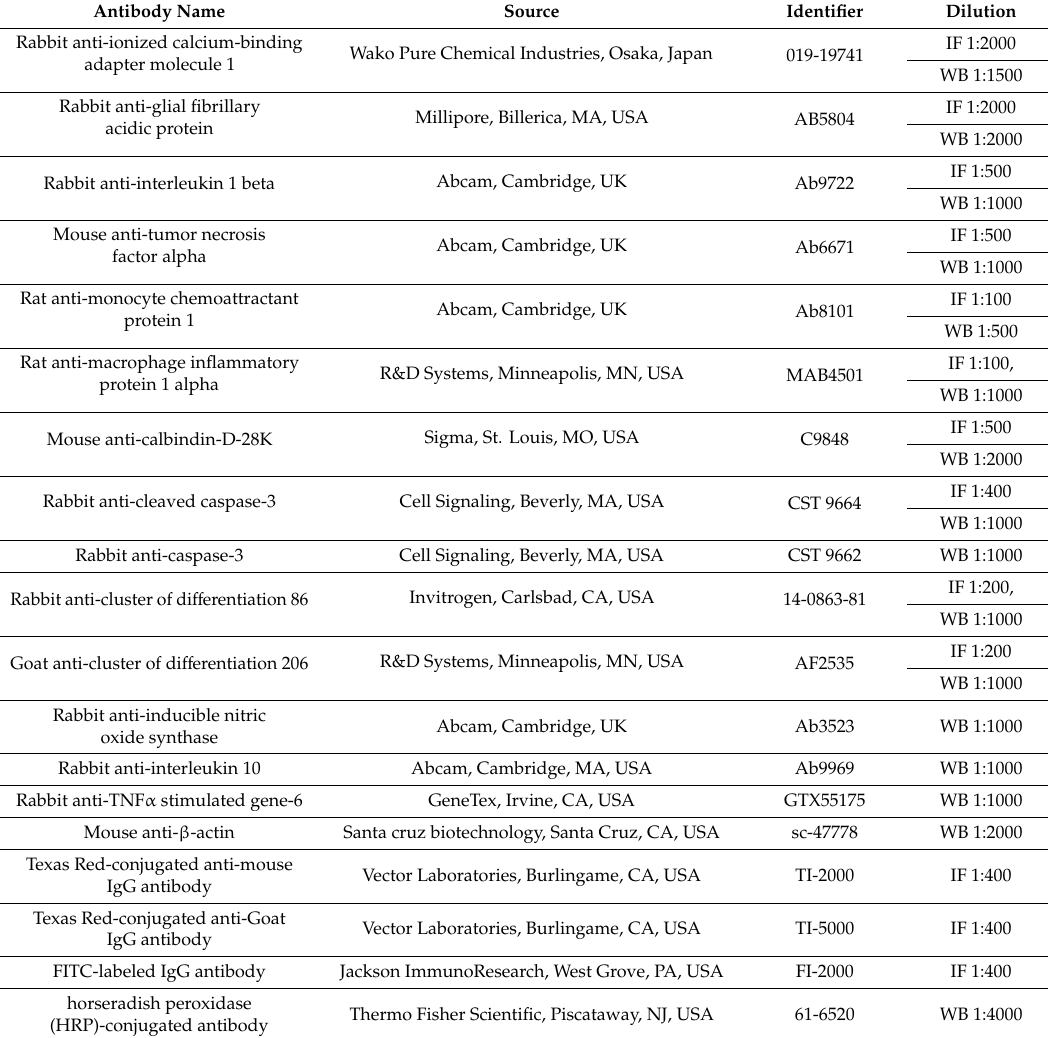
Table 1. List of antibody used for immunofluorescence (IF) staining and western blot